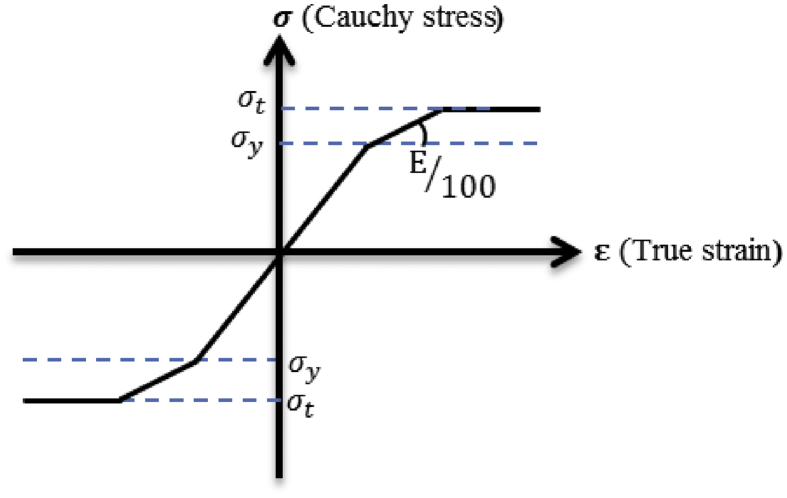
Stress-strain curve.